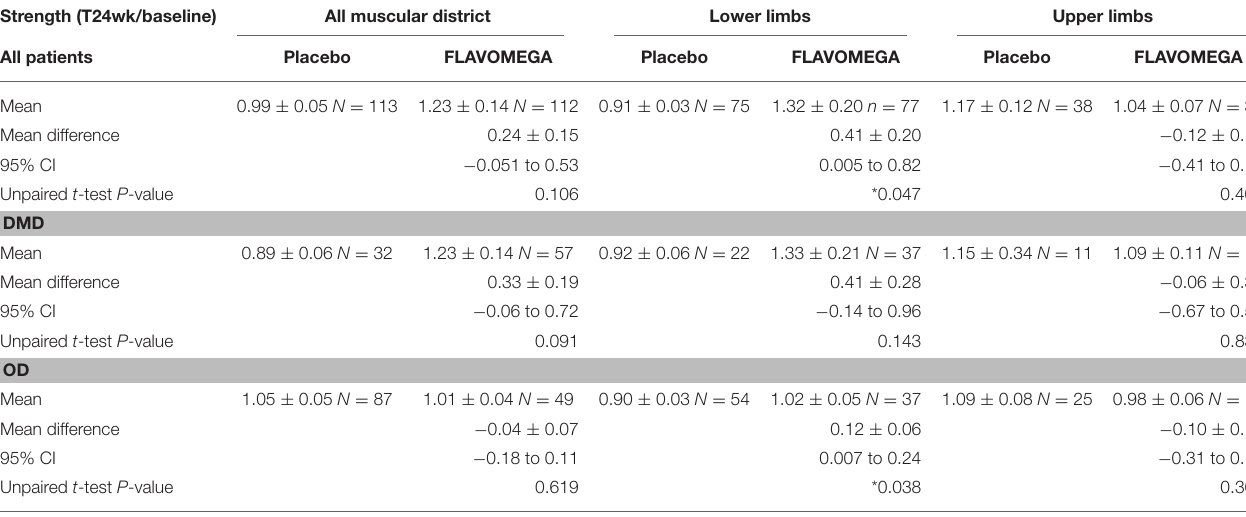
TABLE 10 | Biodex measurements of strength as T24wk/baseline ratio and unpaired t -test between Placebo and FLAVOMEGA treated groups. Strength